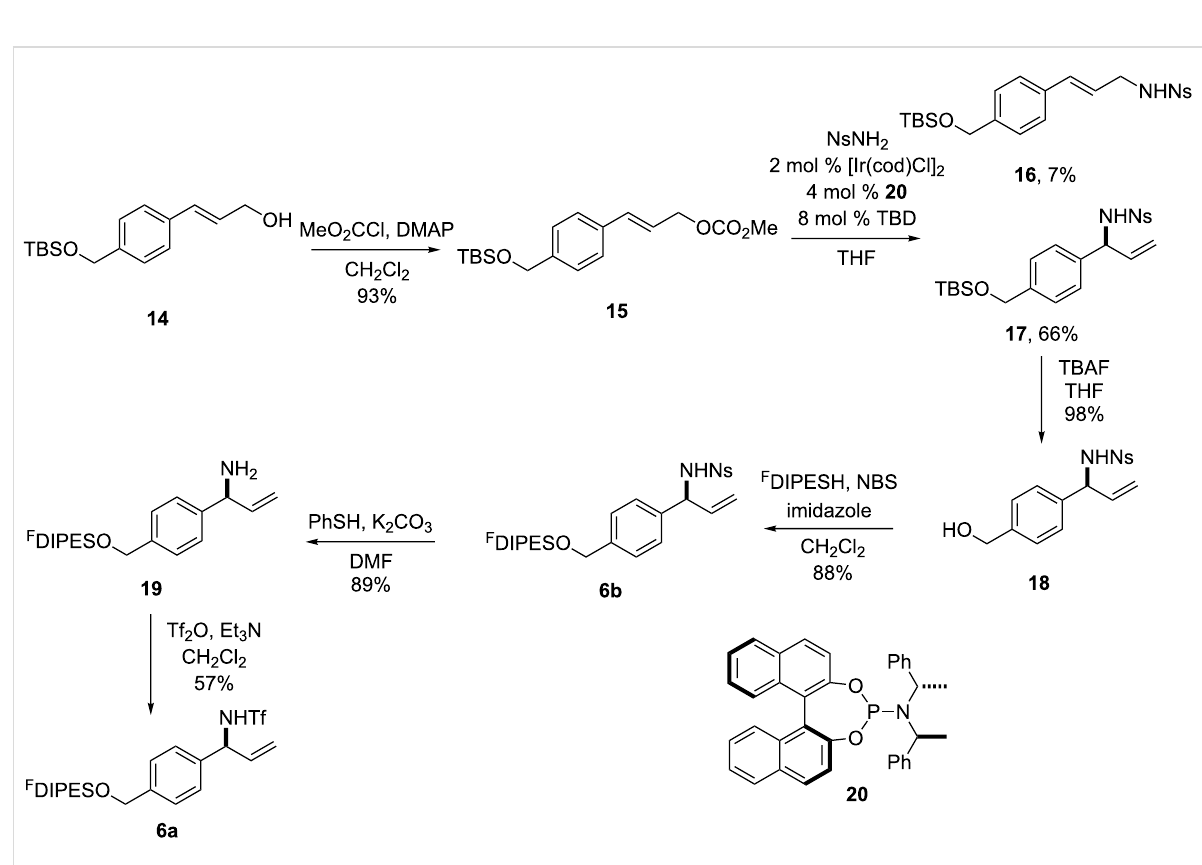
Figure 1: Structures of building blocks used in this study. Panel A: fluorous-tagged initiating building blocks. Panel B: propagating building blocks. Panel C: terminating building